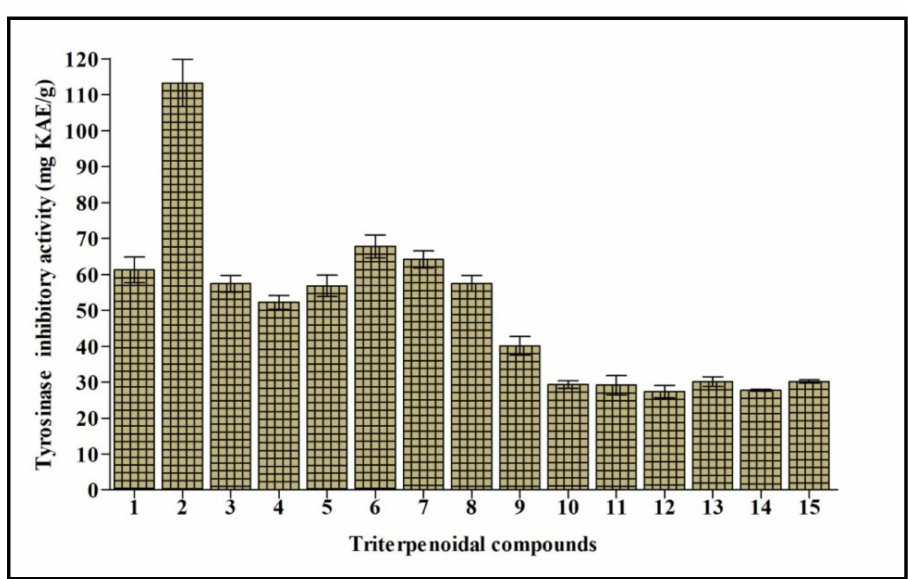
Figure 4. Tyrosinase inhibitory activity of fifteen triterpenes expressed in mg KAE/g. Values are reported as mean ± S.D.; KAE: Kojic acid equivalent. Different letters indicate significant differences in the tested compounds ( p < 0.05).